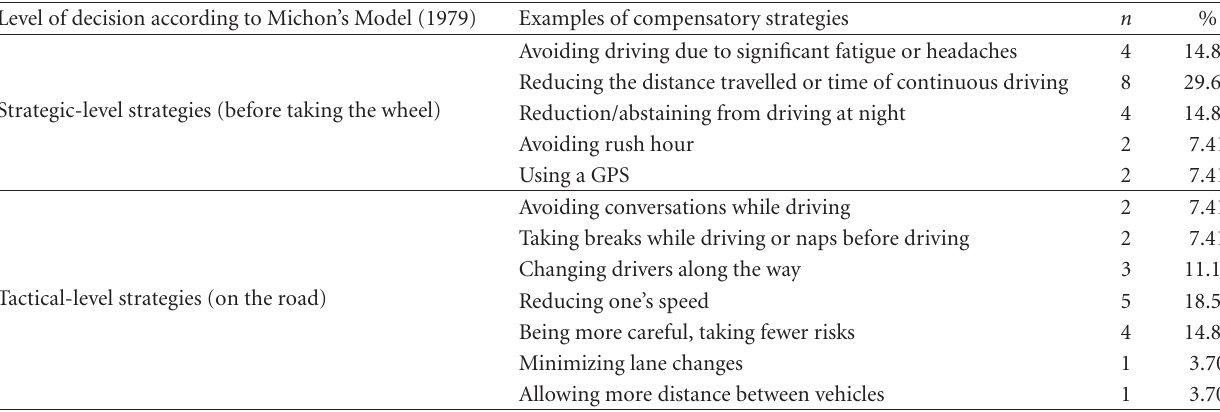
Table 5: Compensation strategies identified by participants.